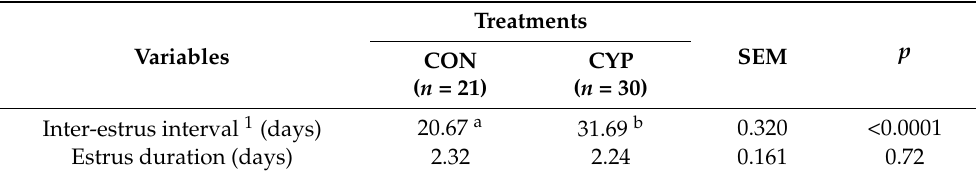
Table 1. Duration of the estrous cycle and estrus of gilts subjected to the estrus synchronization protocol using estradiol cypionate and PGF2 α